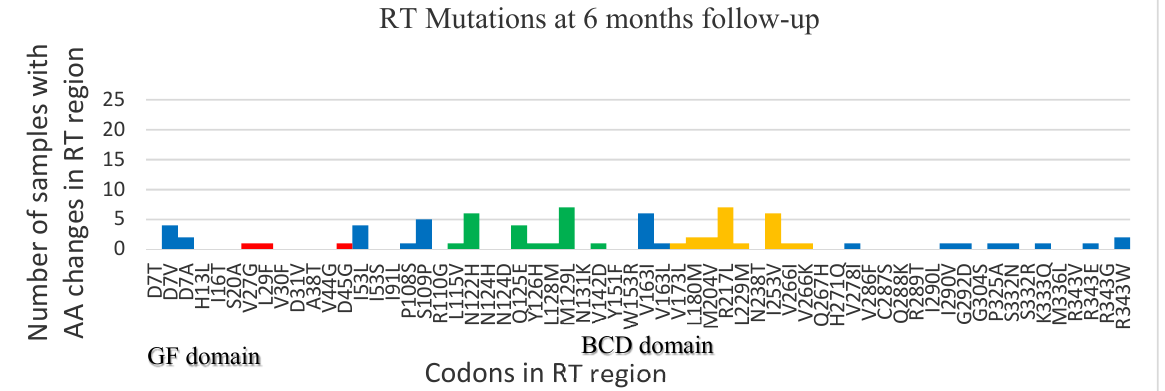
Figure 2. Patterns of HBV RT mutations observed at first and second visit. Red-shaded bars show mutations in the G and F domains of the reverse transcriptase (RT) region, yellow bars show mutations in the B, C and D domain of RT, which contain catalytic sites, whilst the green bars show the area where changes in pol result in s-gene mutations in overlapping frame